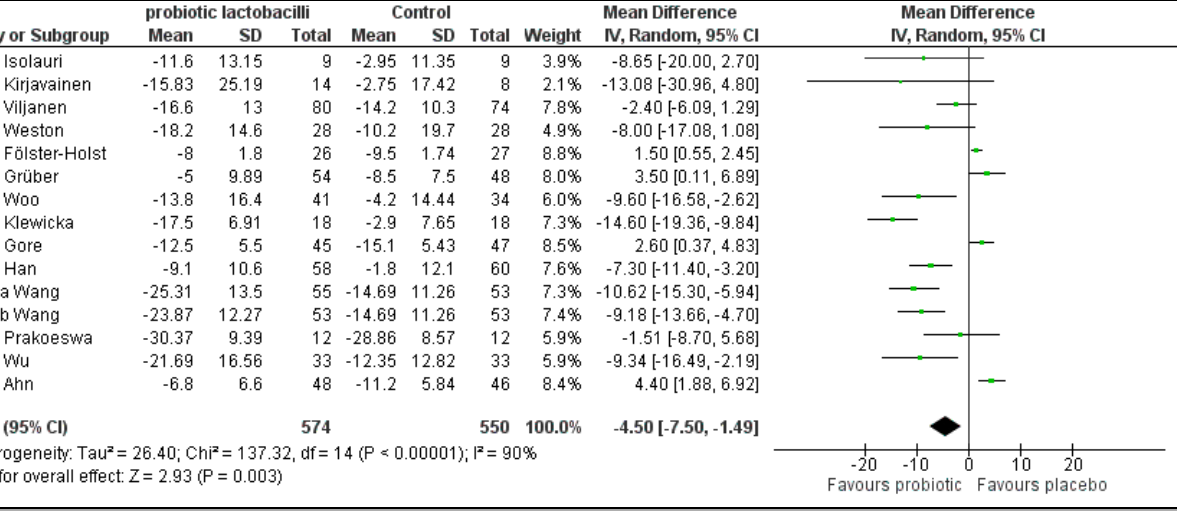
Figure 2. Meta-analysis of the effect of single-strain probiotic lactobacilli compared to placebo on the SCORAD index change in children with AD [41–44,46–55].